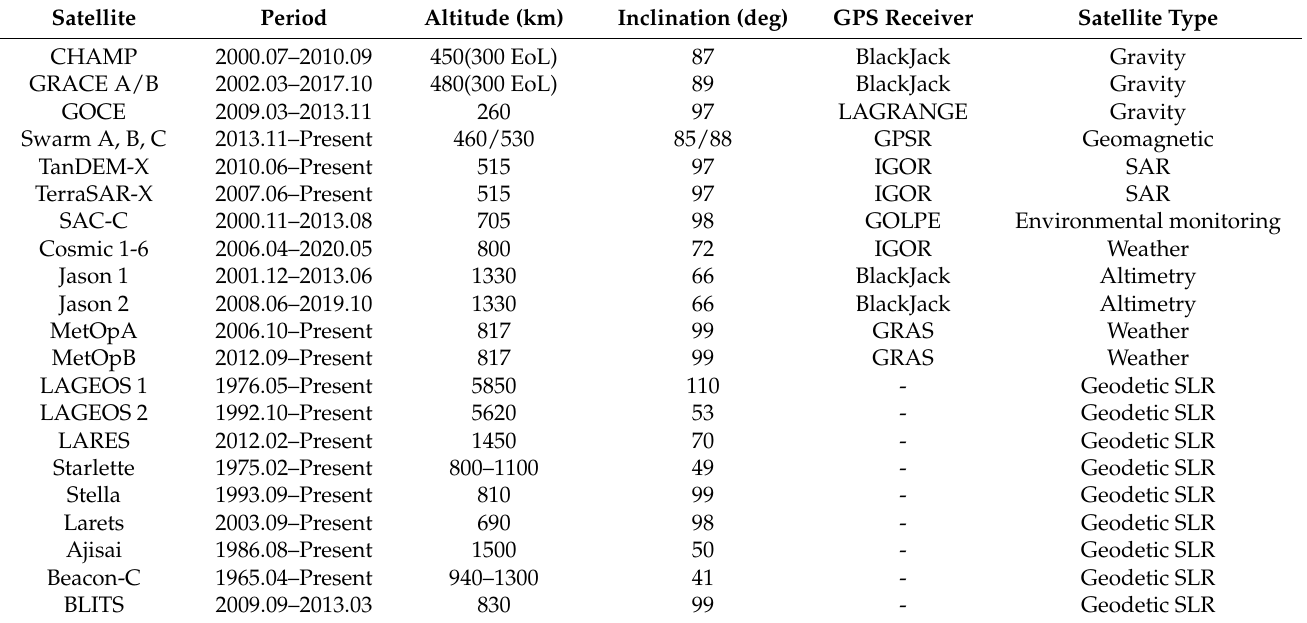
Table 1. Orbit and other properties of all the HLSST LEO satellites and SLR satellites used in the HLSST+SLR solutions. “Present” in the Period column means that the mission is still in operation. The Swarm mission is a three-spacecraft constellation in two orbital